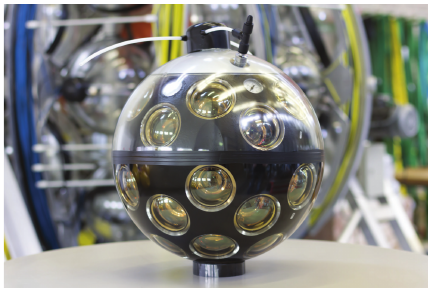
Figure 10: Prototype of a multi-photomultiplier optical module for KM3NeT. The module incorporates 31 3-inch photomultipliers, their high-voltage bases, and the electronic modules for signal digitization and communication to shore. Photograph by KM3NeT Collaboration.